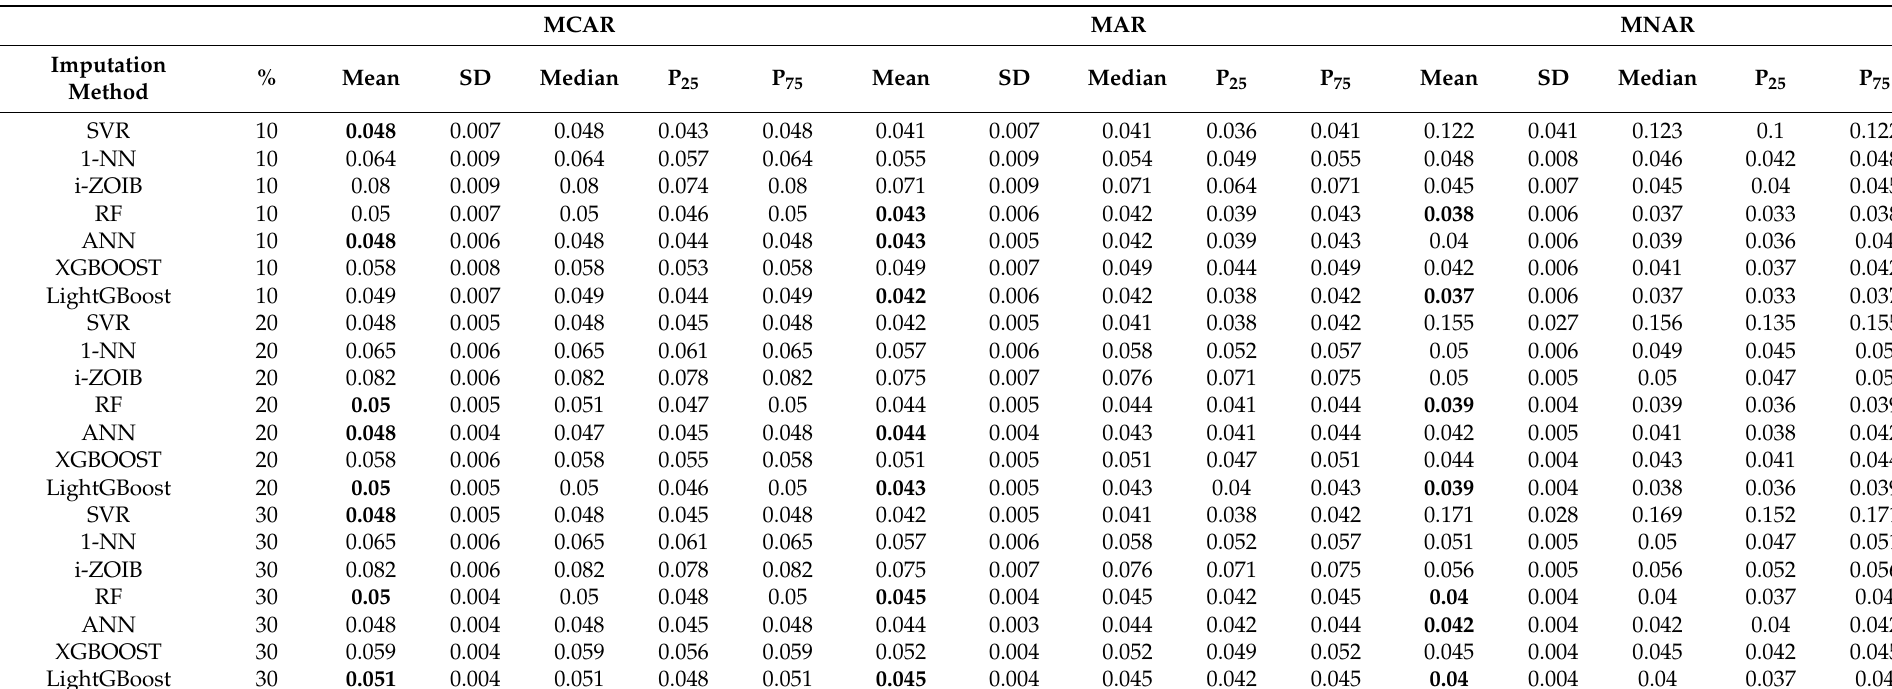
Table A6. Summary statistics of the RMSE accuracy measure according to the missingness mechanisms, rates and imputation methods in the Scenario 3. MCAR MAR